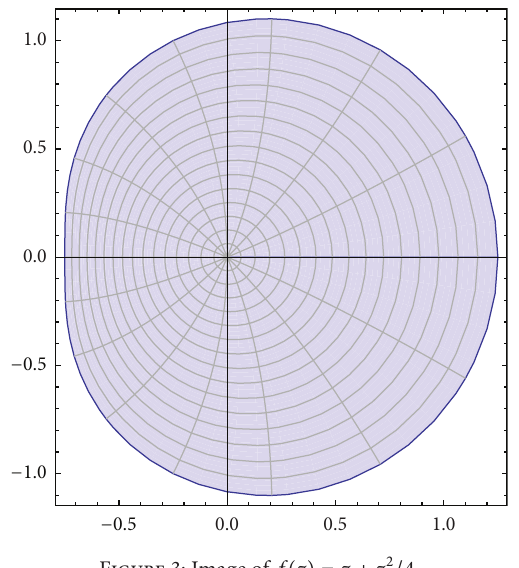
Figure 3: Image of 𝑓(𝑧) = 𝑧 + 𝑧 2 /4 .